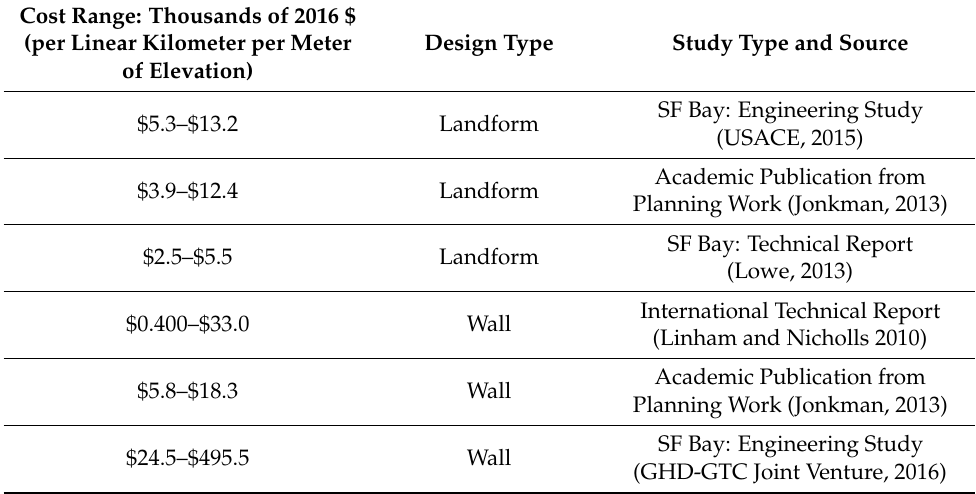
Table 1. Sources and range of associated unit costs converted to thousands of 2016